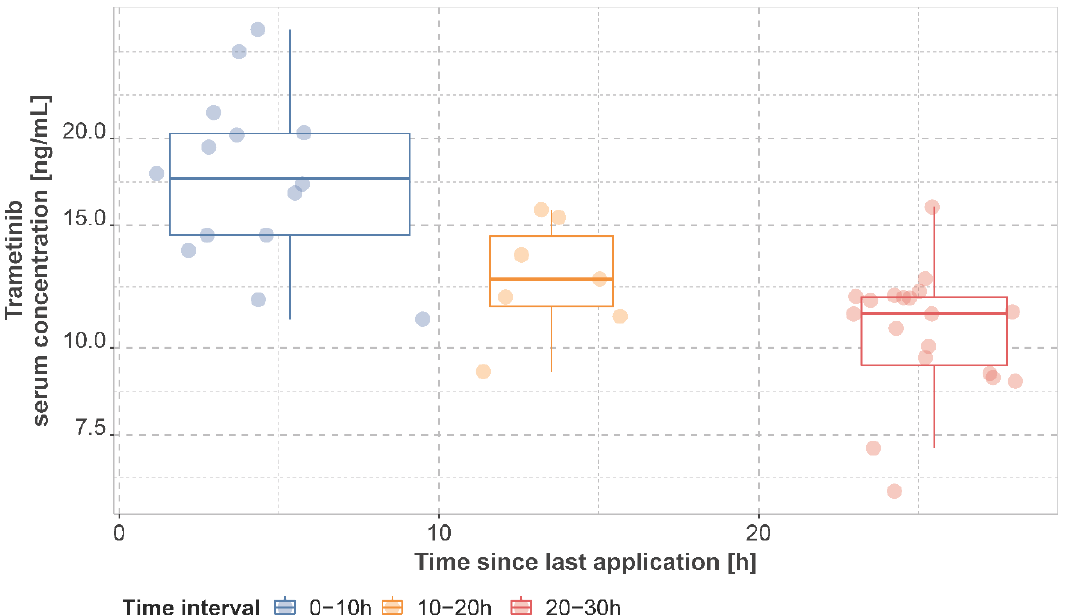
Figure 2. Observed hydroxy − dabrafenib (A) and dabrafenib (B) serum concentrations . Concentra- tions are presented as mean concentration per patient at steady state stratified by sampling time interval. Patients may have contributed samples at multiple time intervals.